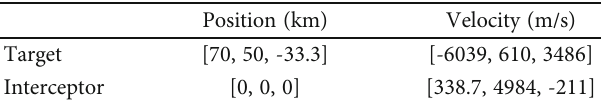
Figure 8: DQN cumulative reward change. Table 4: Simulation initial